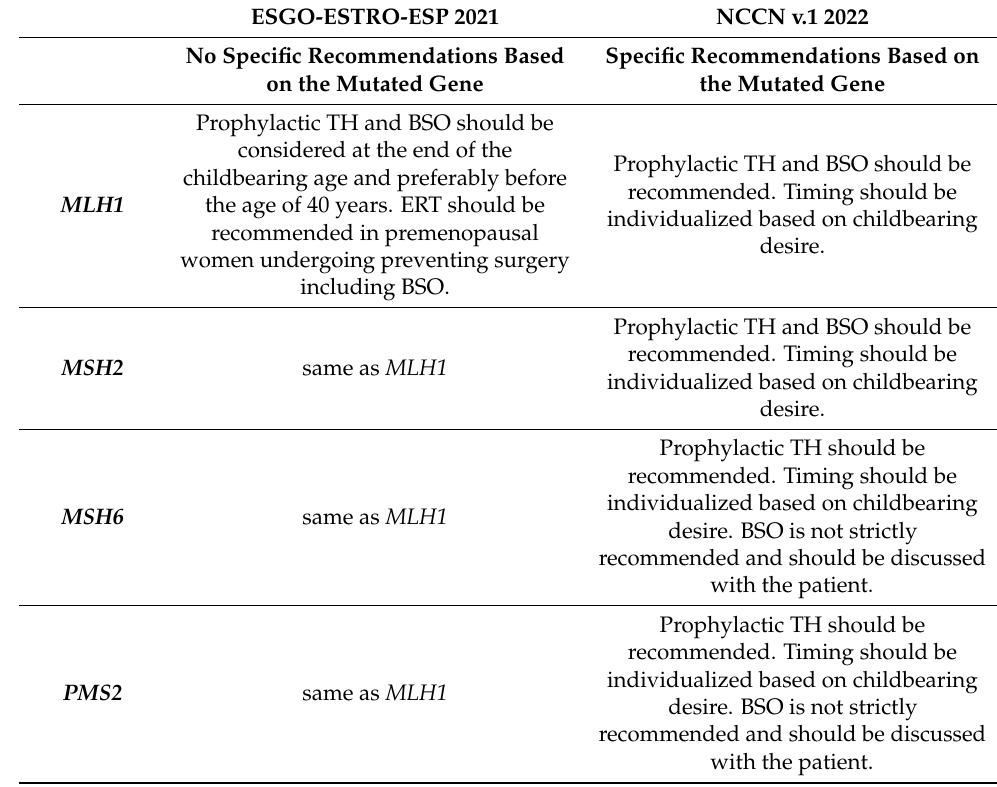
Table 1. Recommendations on prophylaxis of gynecologic cancers for Lynch Syndrome carriers based on the ESGO-ESTRO-ESP 2021 Guidelines and the NCCN v.1 2022 Guidelines. TH: total